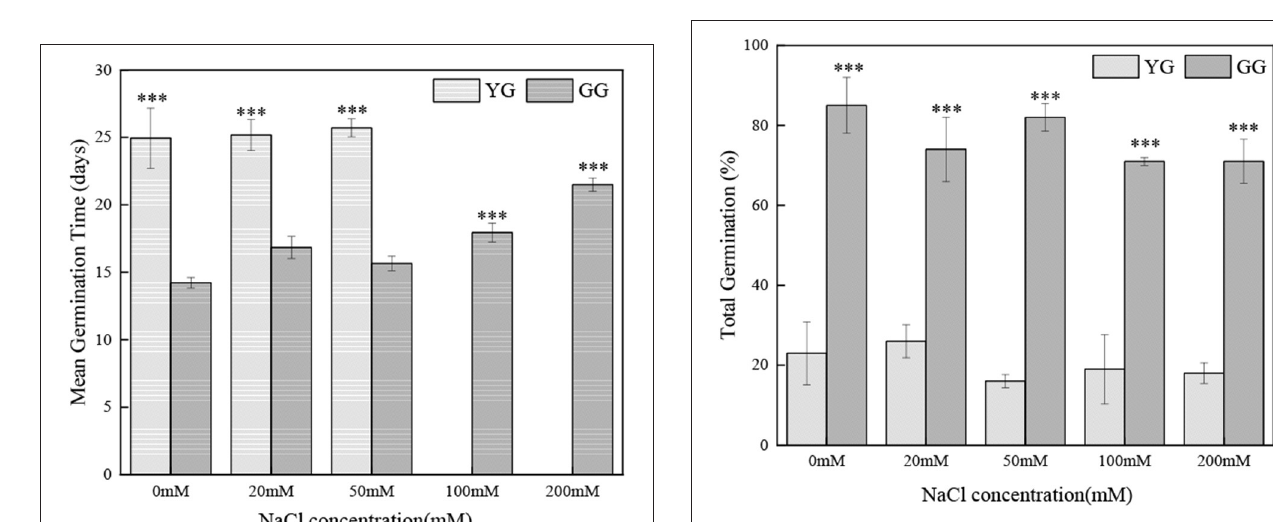
FIGURE 2 | Effects of salt stress on mean germination time of different L. chinensis ecotypes incubated at 28/16 ◦ C (12 h light/12 h dark) for 30 d. There were four replicates for each treatment. Values are means ± standard error (SE). *, **, ***Indicate significant differences between the different ecotypes under the same NaCl concentration at 0.05, 0.01, and 0.001 level respectively, and ns indicates no significant differences.